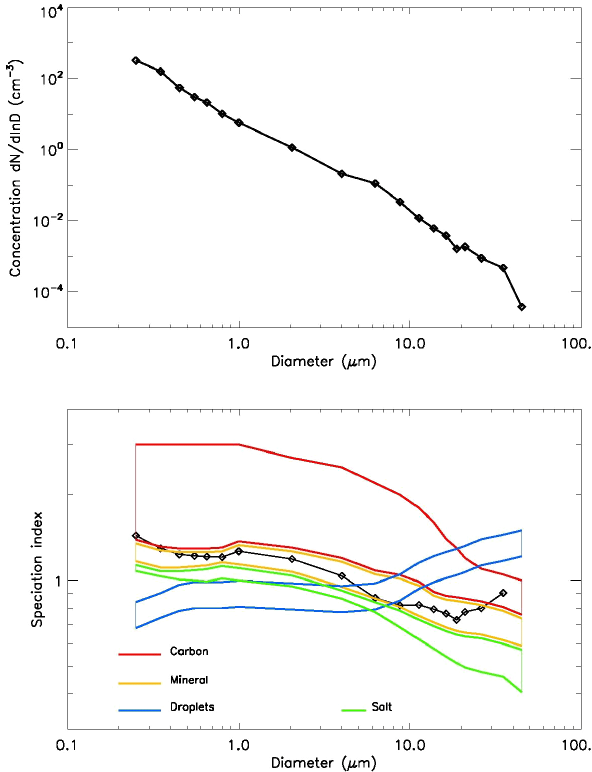
Figure 17. Example of the detection of sand particles above Mediterranean Sea (longitude of 39 ◦ 55 (cid:48) , latitude of 4 ◦ 14 (cid:48) , close to Minorca) from a drifting pressurized tropospheric balloon on 17 June 2013 around 14:30UT at an altitude of 2050m, during the ChArMEx campaign; upper panel: size distribution; lower panel: typology, the LOAC data are in black dots. The LOAC uncertainties are ± 20% for the higher concentrations and ± 60% for the lower